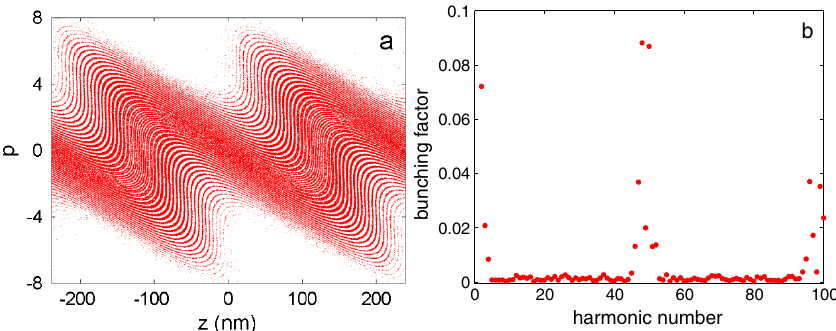
FIG. 11. (Color) (a) Longitudinal phase space at the exit of dispersion 2. (b) Bunching factors for various harmonics.